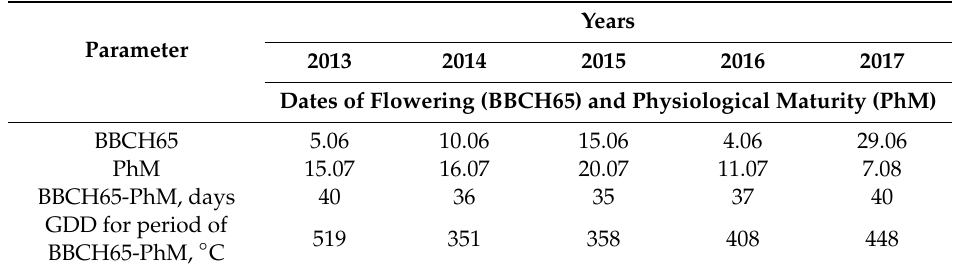
Table 3. Accumulation of growing degree days (GDD; ◦ C) in 2013–2017 and length of grain filling period (from flowering up to physiological maturity).